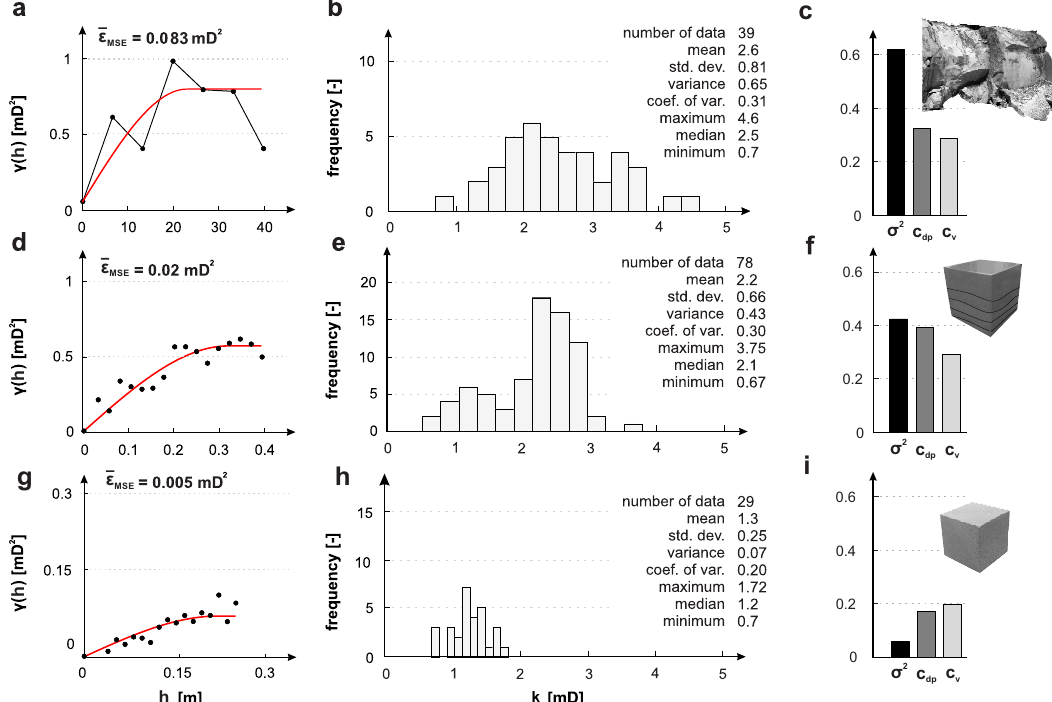
Figure 5. Empirical variogram and variogram model, empirical histogram, and heterogeneity-indexes derived from the k measurements for the outcrop ( a – c ), and the rock cubes OSB1_c ( d – f ) and OSB2_c ( g – i ). A scale-effect is observable in the heterogeneity-indicating coefficient of variation, the Dykstra–Parson coefficient and the sample variance. All variogram models are described by a spherical model with nugget effect. The variogram model for ( a ) is described by n = 0.05 mD 2 , a = 23 m and b = 0.75 mD 2 with n as nugget, a as range, and b as sill. The model for ( d ) is described by n = 0 mD 2 , a = 0.3 m and b = 0.58 mD 2 while the model of ( g ) is described by n = 0.005 mD 2 , a = 0.18 m and b = 0.08 mD 2